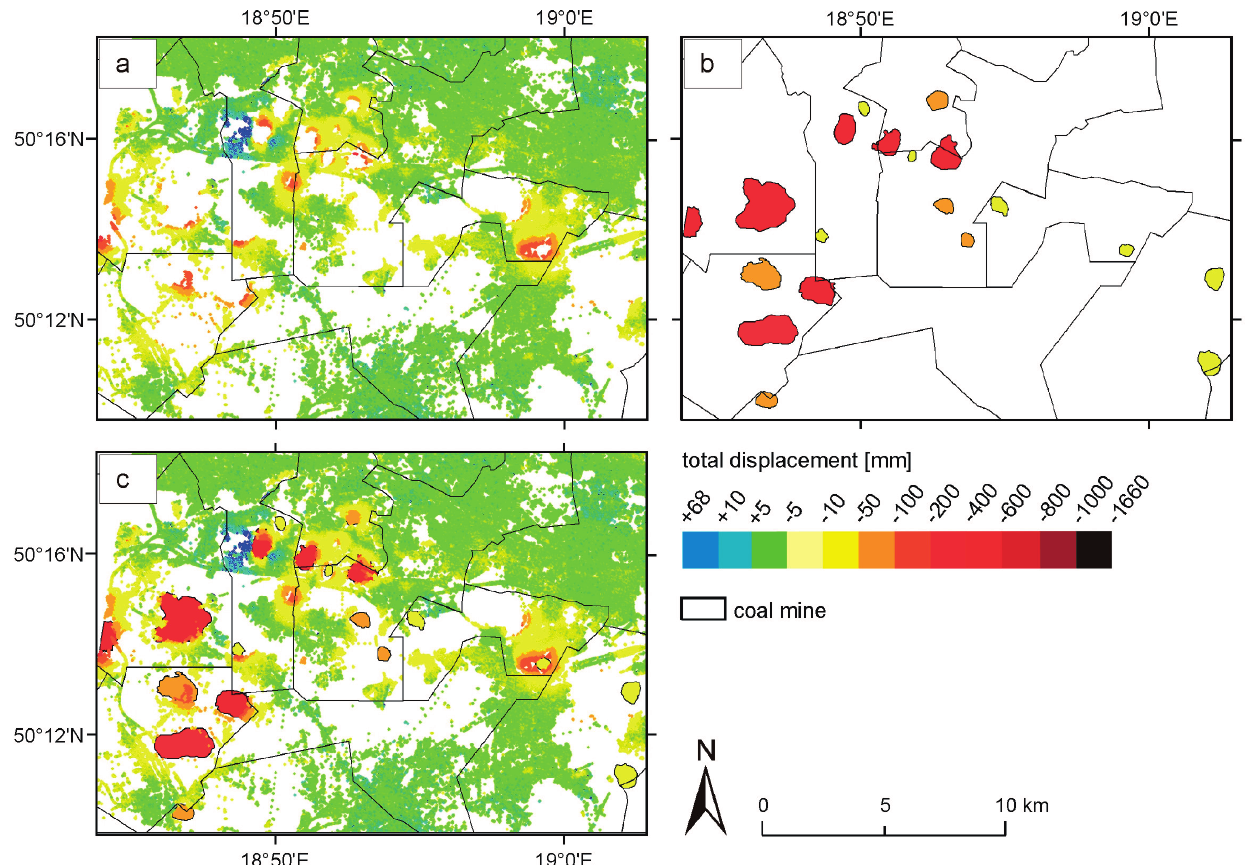
Figure 9. Cumulated displacements in the Upper Silesia Coal Basin, Katowice and Ruda Ś laska area. ( a ) Permanent Scatterers Interferometry (PSI) cumulated displacement; ( b ) cumulated displacement measured for the subsidence troughs derived from conventional Differential Synthetic Aperture Radar Interferometry (DInSAR); and ( c ) PSI cumulated displacement values superimposed on the subsidence troughs derived from conventional DInSAR. Common color scale is used both for PSI and the troughs cumulated displacement value, with this remark that for the trough (b,c), the value refer only to the maximum detected subsidence within the whole active